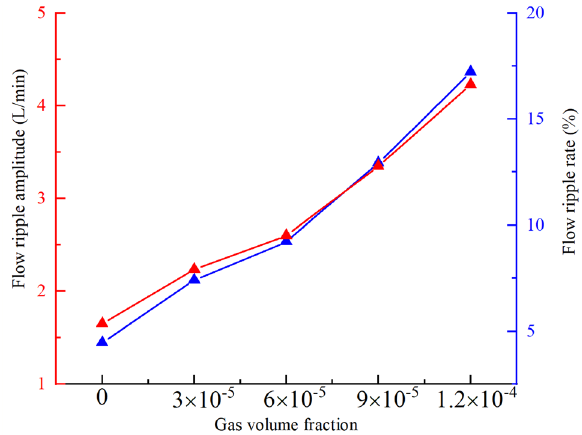
Figure 22. Influence of gas volume fraction on flow ripple